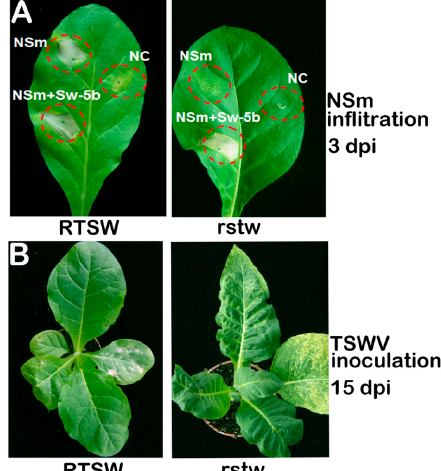
Figure 6. Development of an avirulent (Avr) gene-based diagnostic approach. ( A ) Necrotic response (HR lesions) was only observed in leaves of tobacco plants carrying the RTSW gene after transient expression of NSm. Co-infiltration of NSm with Sw-5b (NSm + Sw-5b) was used as a positive control, and agroinfiltration of empty vector was used as a negative control (NC) in each leaf. Photographs of leaves were captured at 3 dpi. ( B ) Typical symptom of TSWV in leaves of tobacco plants carrying the RTSW gene (K326 RTSW ) or lacking the RTSW gene (K326 rtsw ).